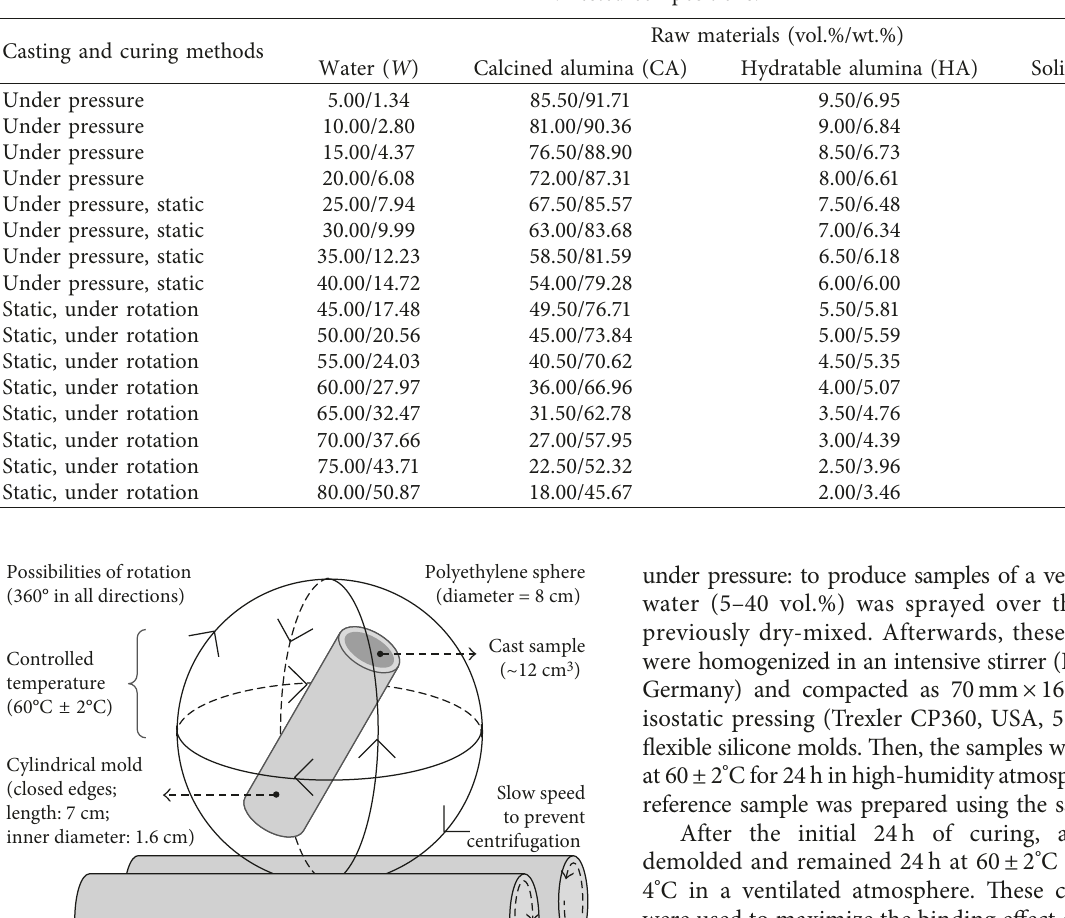
Table 2: Tested compositions.